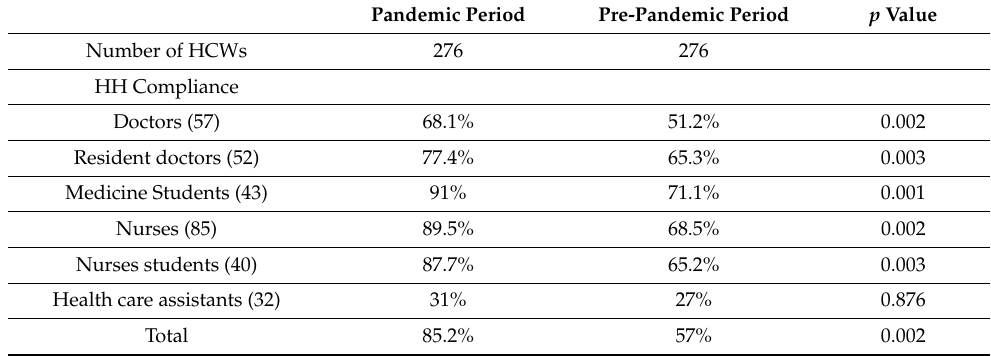
Table 1. Hand hygiene (HH) compliance among the healthcare workers (HCWs).